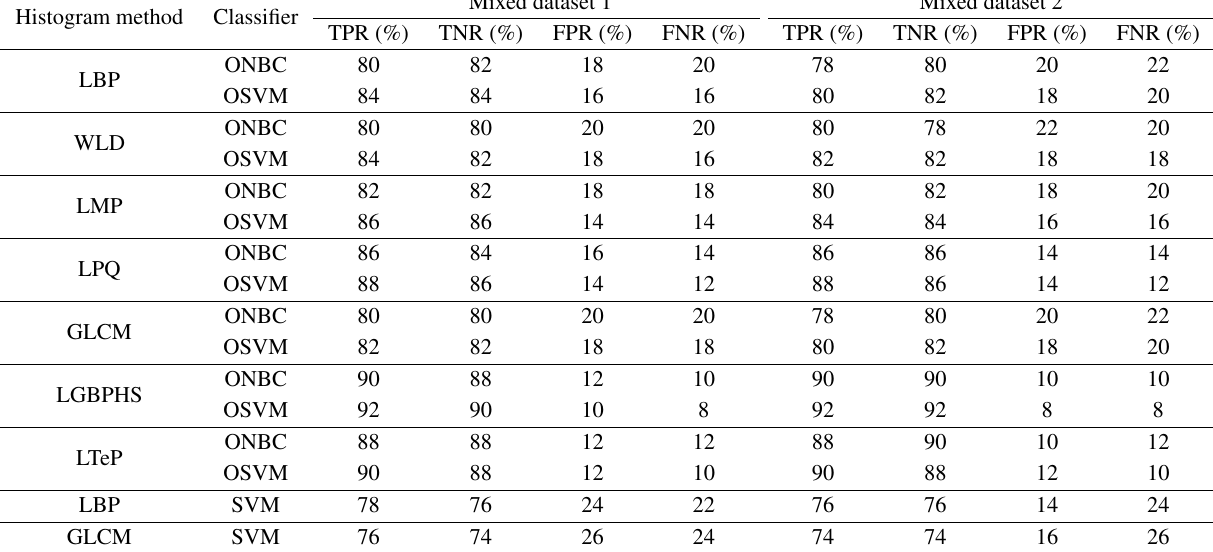
Table 6 Performance of CMFD algorithms with mixed datasets 1 and